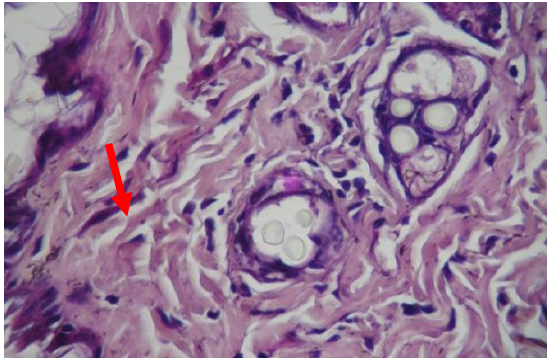
Figure, 8: Section in the skin of infected non- immunized animal at day 30post challenge show hair follicle with purplish microfilament (PAS stain 400X).